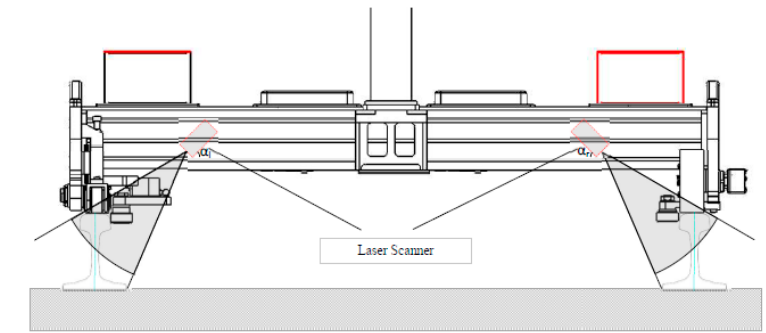
Figure 6. Inspection trolley for 3D reconstruction, based on laser profilometers [32].